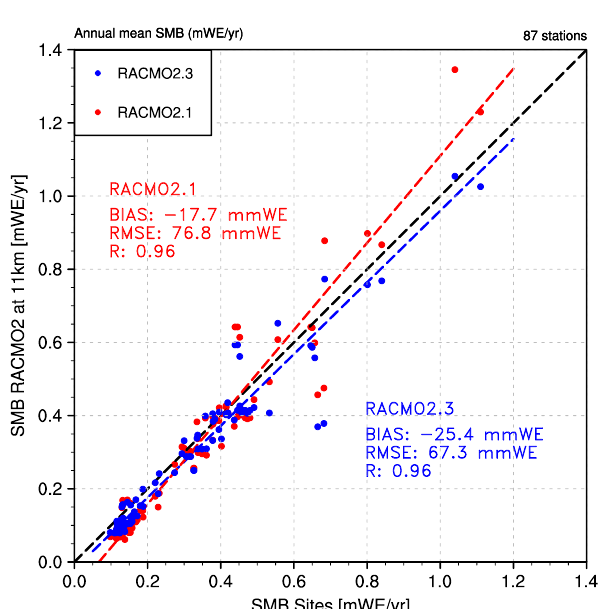
was obtained. At station S5 in the lower ablation zone, sum- mer albedo in RACMO2 is mainly determined by the pre- scribed MODIS ice albedo, due to near-continuous bare ice exposure. The updated physics in RACMO2.3 have consid- erably improved the modelled SMB gradient along the K- transect when compared to ablation stake measurements, re- ducing the bias by 43